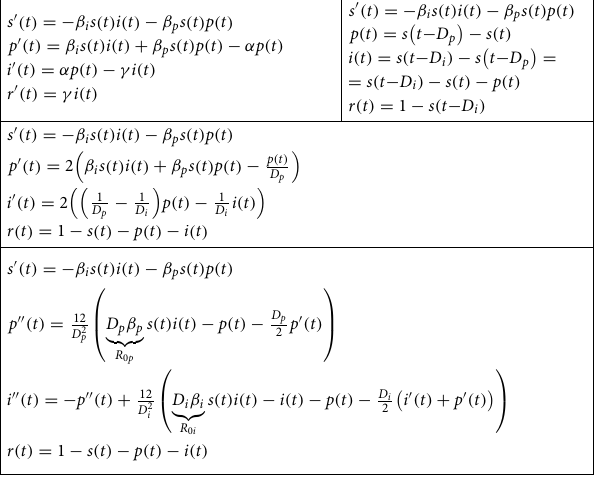
Table 1. Equations for SPIR, dSPIR, Padé-1 SPIR and Padé-2 SPIR models. Note the correspondence def = 1 , D + 1 > D p . Also note that if β i = β p , treating p ( t ) + i ( t ) as a single variable renders the SPIR D p def = 1 i α α γ structures similar to the SIR structures with similar